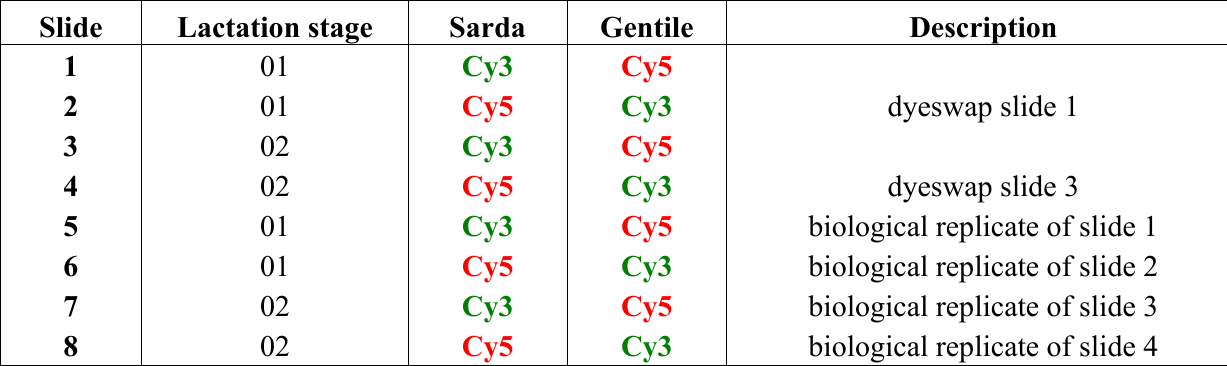
Table 1. Microarray experimental